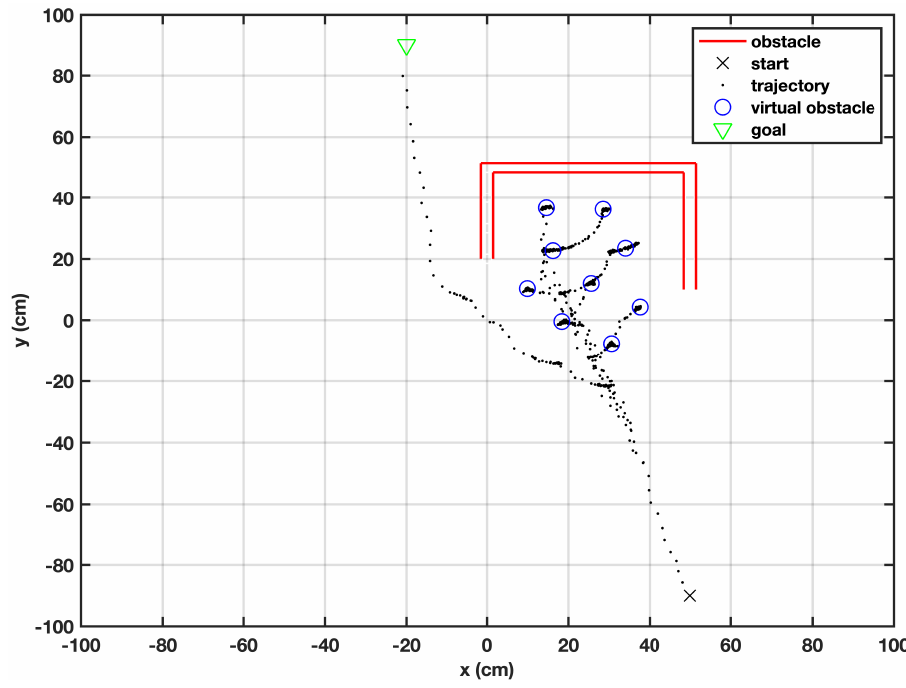
Figure 9. Behavior of the robot when U-shaped obstacle is